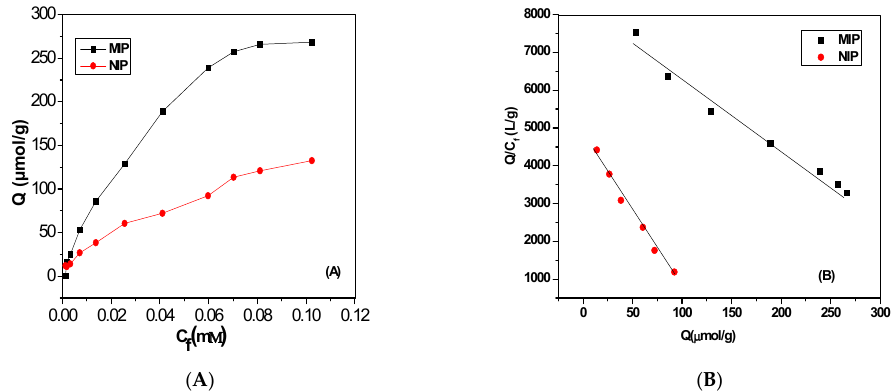
Figure 3. Binding characteristics of the prepared beads: ( A ) binding isotherms and ( B ) Scatchard plot.